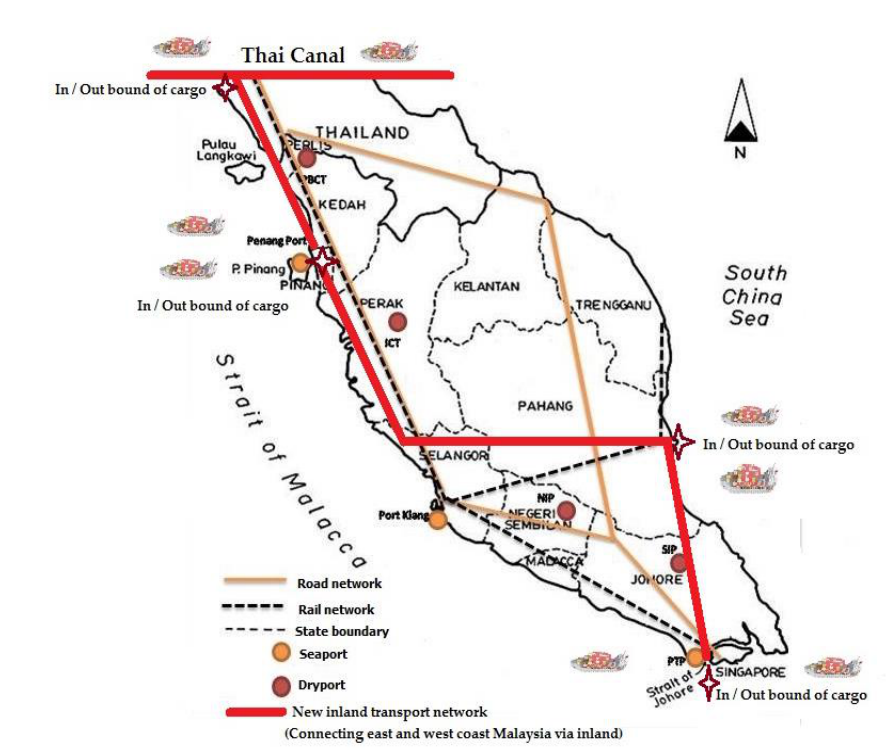
Figure 4: Inland detour connecting east and west coast